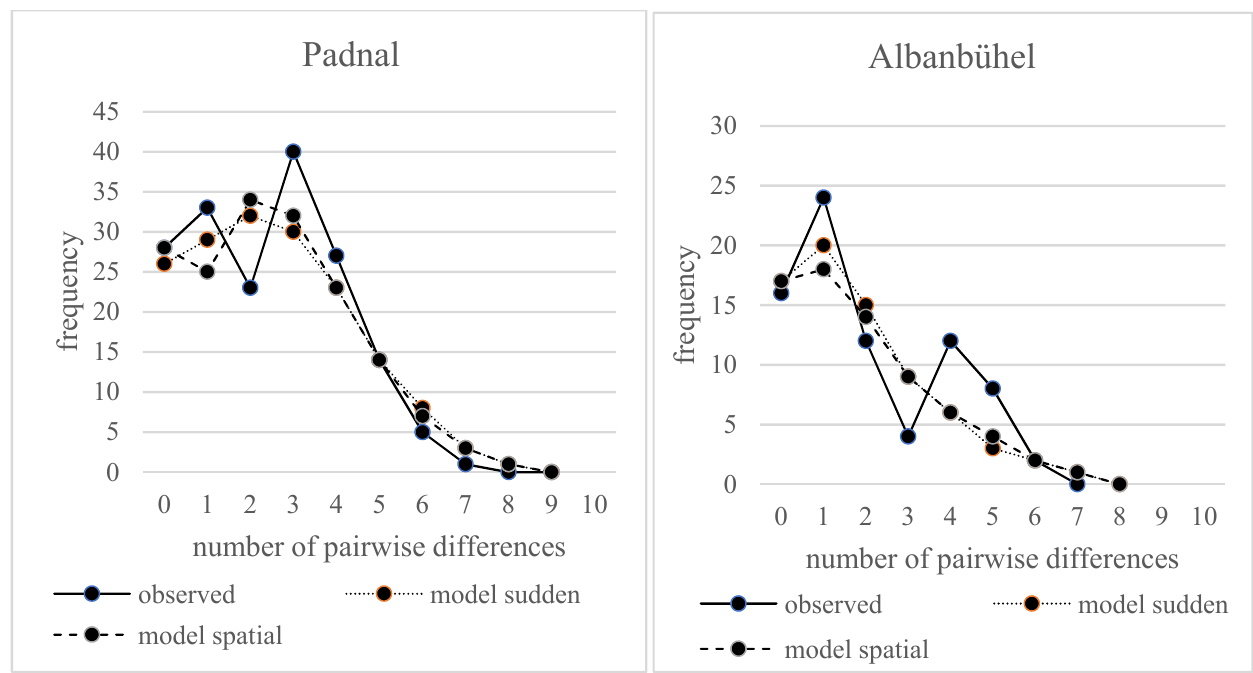
Figure 3. Mismatch distribution of cattle from the sites Savognin Padnal and Albanbühel. The F st value of − 0.013 (a negative F st value corresponds to zero, p = 0.59) is not significant and indicates no structuring between both